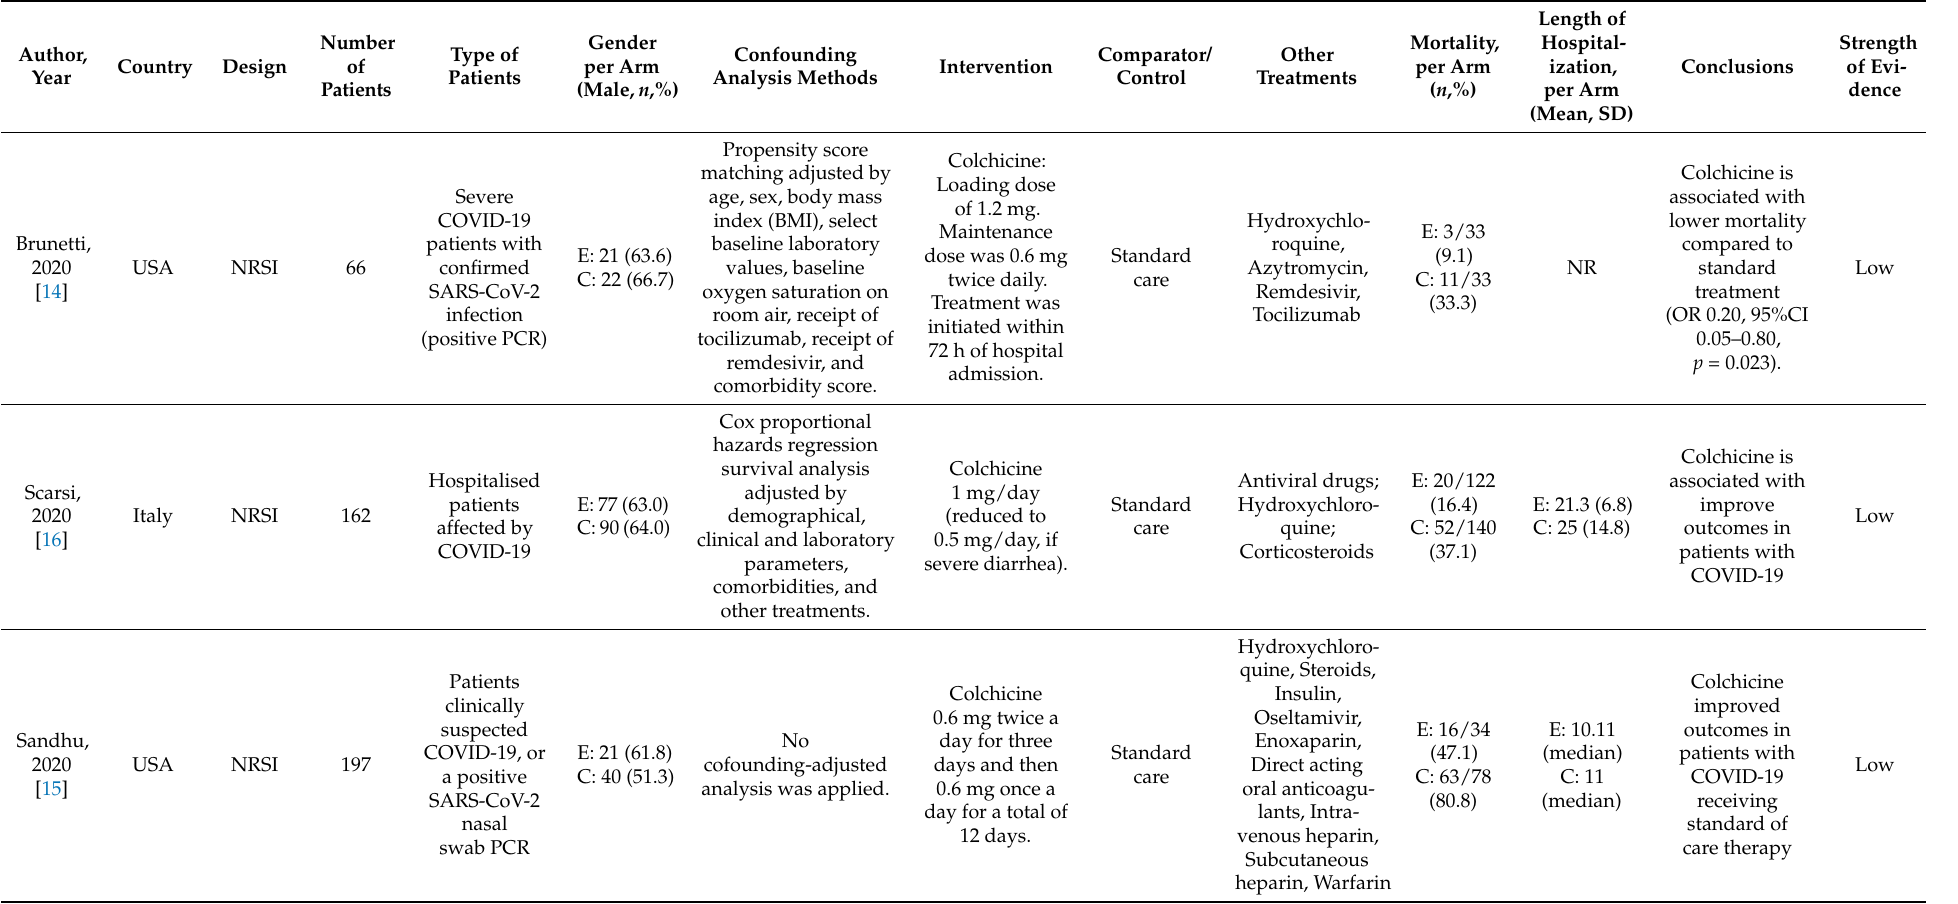
Table 1. Characteristic of included